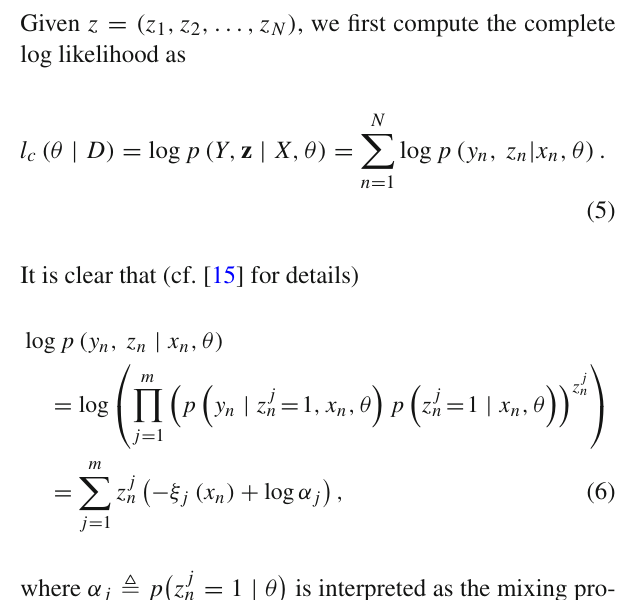
x n resides outside the hypersphere and moves apart from